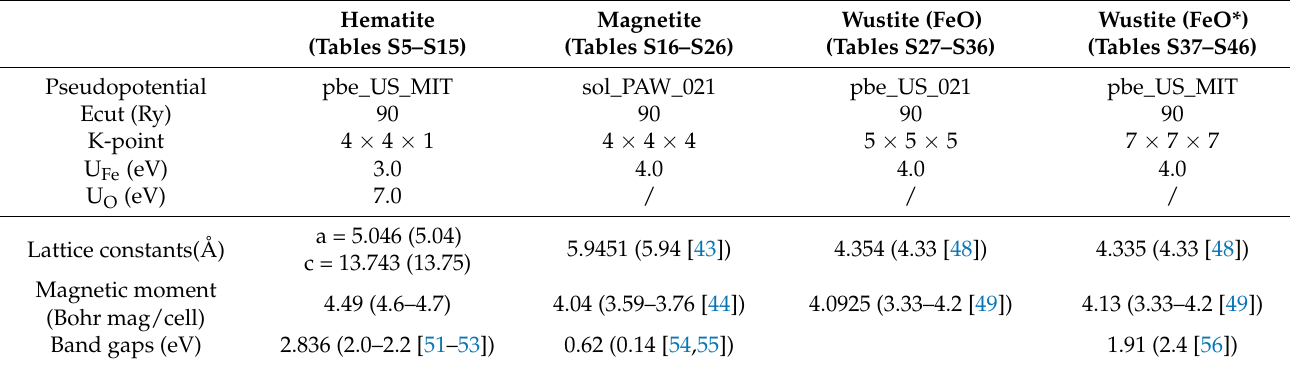
Table 2. The optimal parameters and results for the three iron